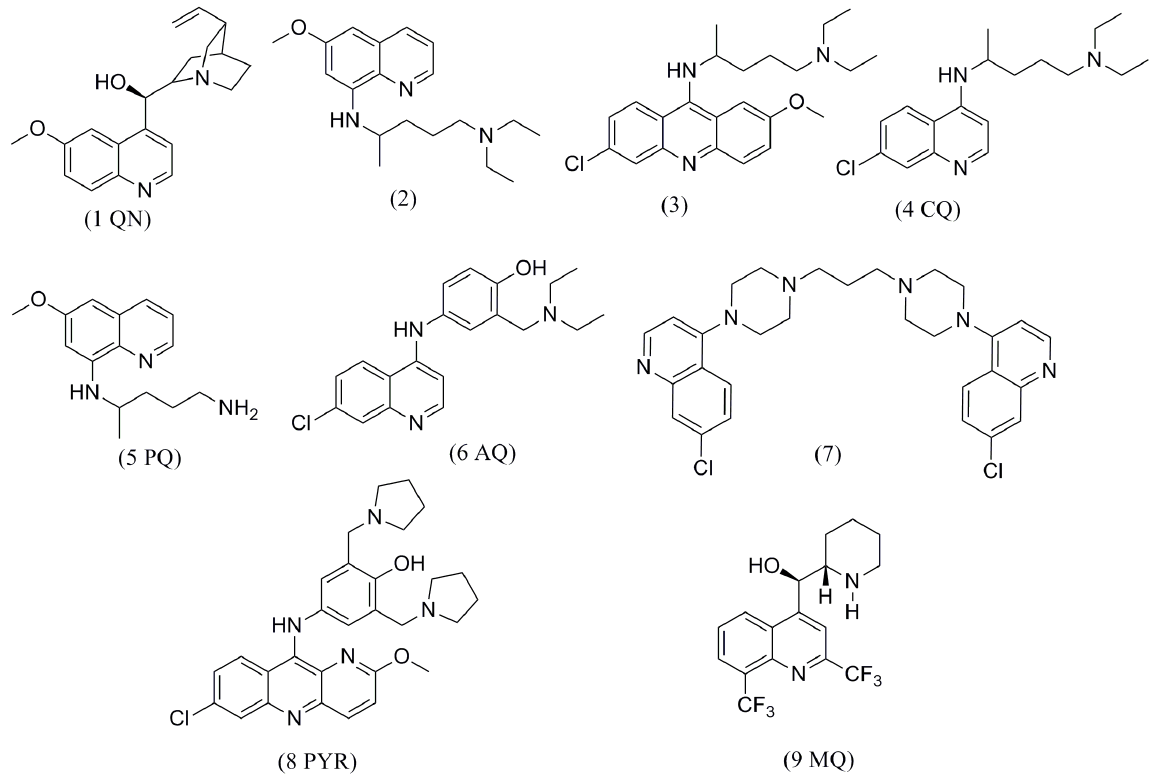
Figure 2 - Quinoline derivatives used in the treatment of